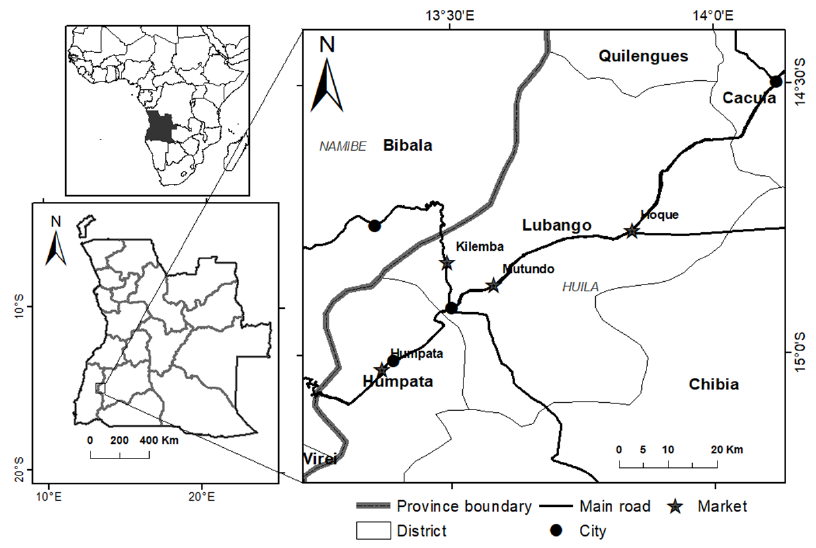
Figure 1. Location of the study site in Angola.